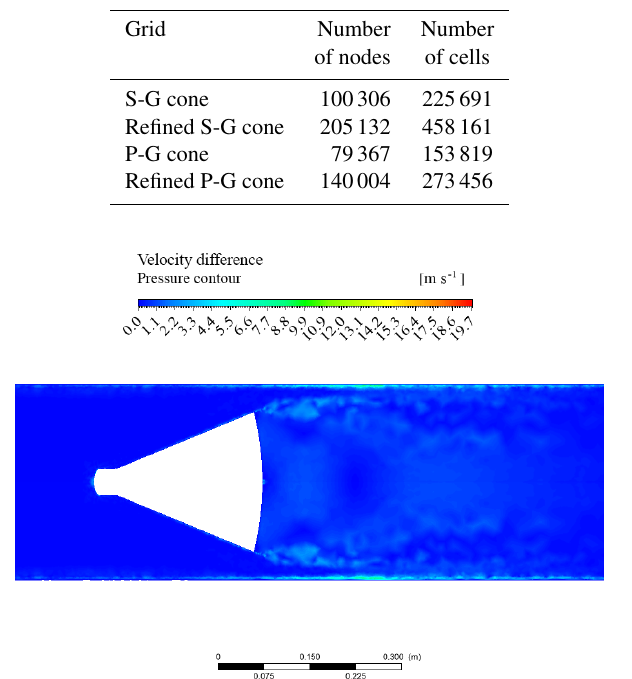
Table 4. Mesh metrics for both geometries.